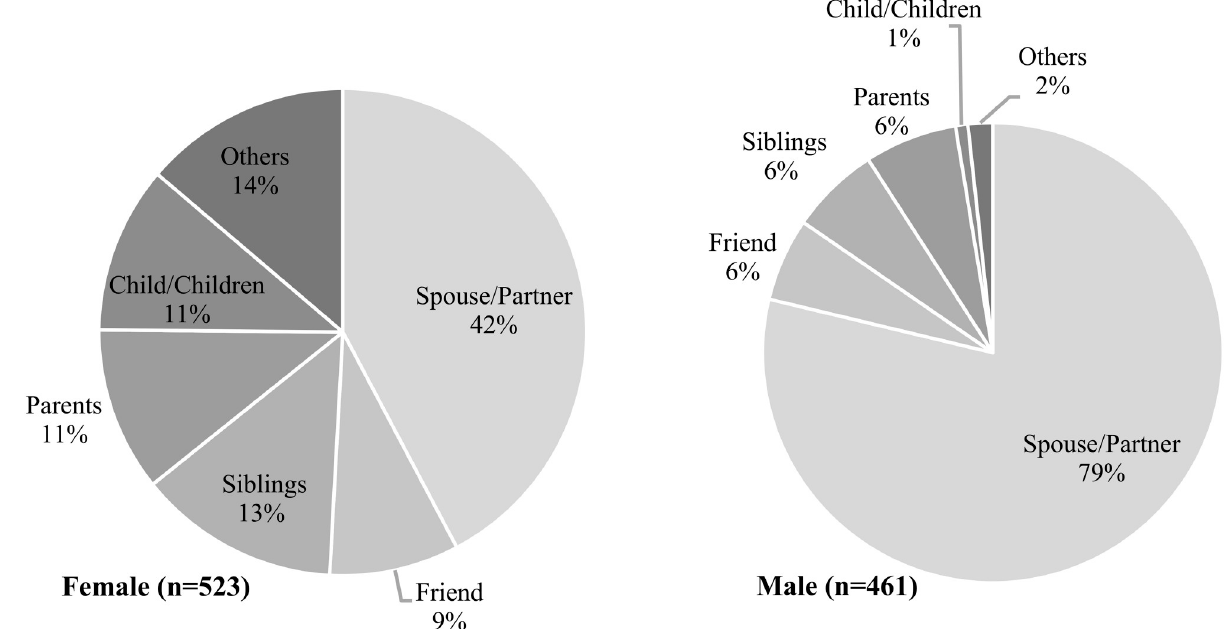
Fig 2. Types of individuals to whom PLHIV first disclosed their HIV status, by sex (n = 984). The graph shows the proportion (%) of individuals to whom PLHIV first disclosed their HIV status (n = 984, F(4.18, 45.94) = 20.7750, p < 0.001). Data shown are coloumn percentages, by sex. Test statistic is adjusted for clustering at the